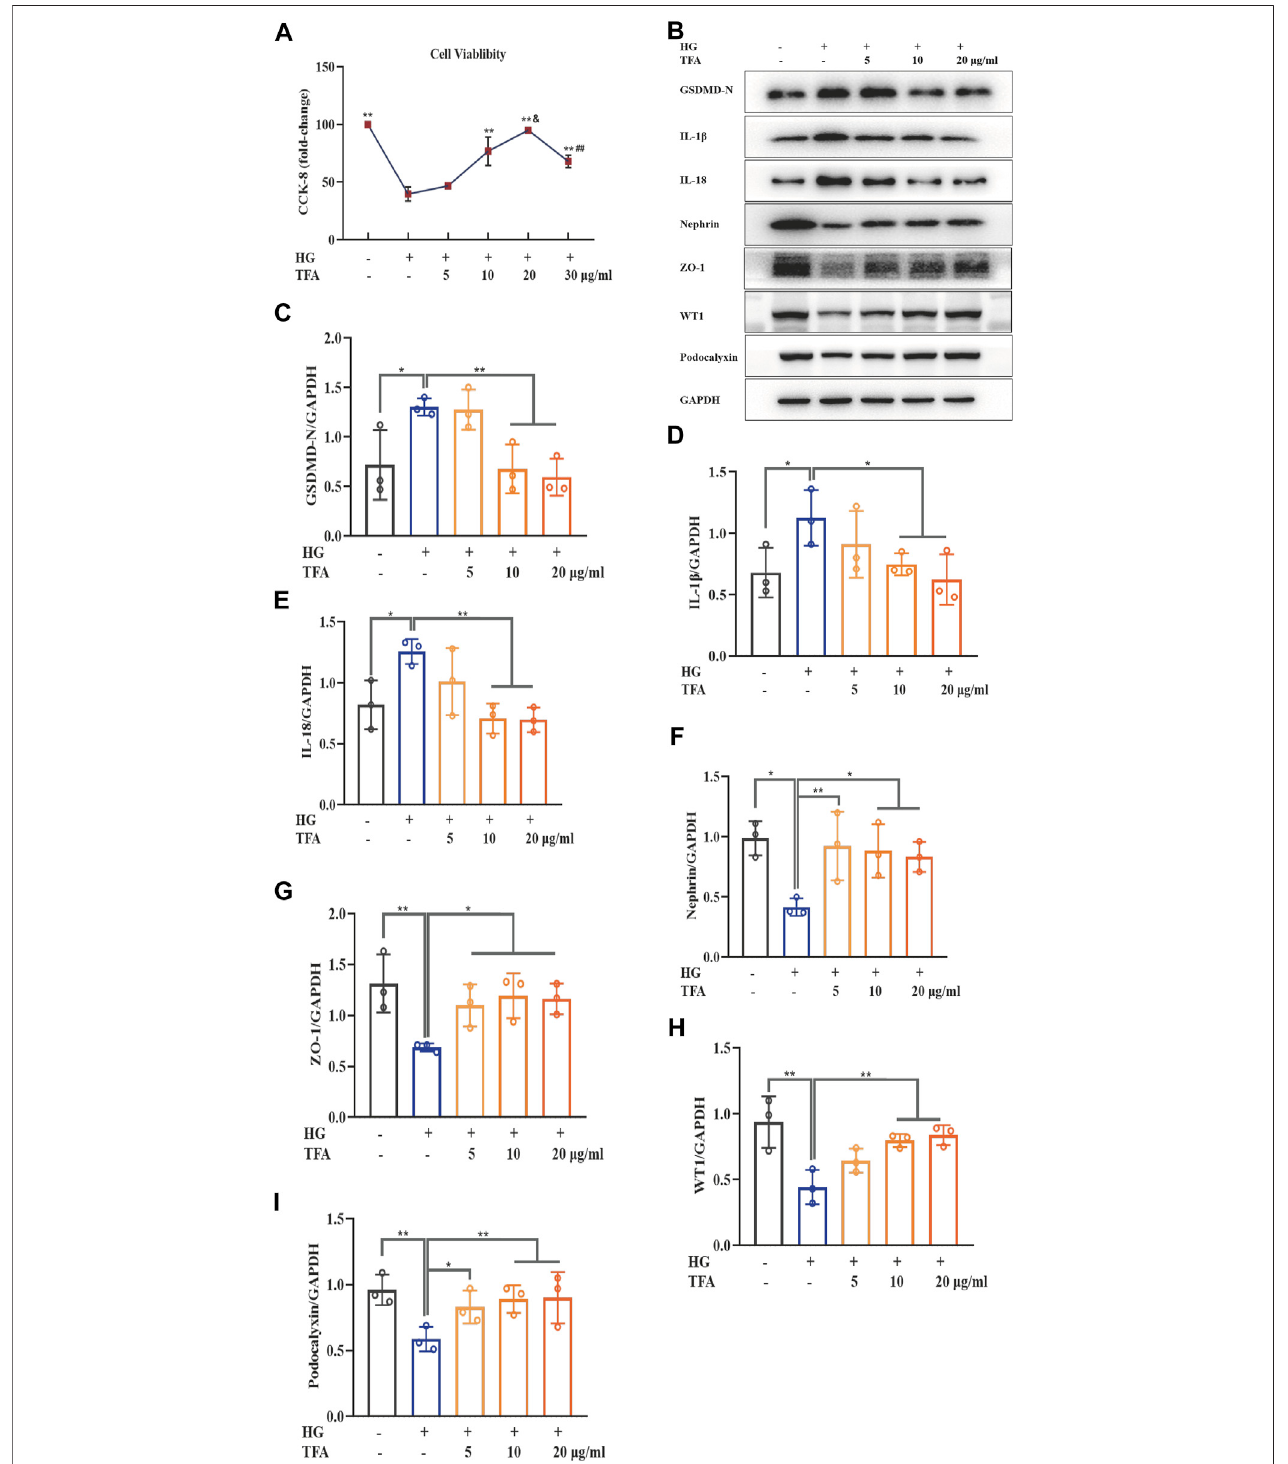
FIGURE1| TFAamelioratedpodocytepyroptosisandinjuryinducedbyHGinMPC-5cellsinadose-dependentmanner. (A) ThecellviabilityinculturedMPC-5cellsexposedtoHGat 30 mMfor48 hwithorwithoutTFAat5,10,20,and30 μ g/mlfor24 h; (B) WBanalysisofGSDMD-N,IL-1 β ,IL-18,nephrin,ZO-1,WT1andpodocalyxininculturedMPC-5cellsexposedto HGat30 mMfor48 hwithorwithoutTFAat5,10,and20 μ g/mlfor24 h; (C) GSDMD-Nwasquanti fi edbydensitometry; (D) IL-1 β wasquanti fi edbydensitometry; (E) IL-18wasquanti fi ed by densitometry; (F) Nephrin was quanti fi ed by densitometry; (G) ZO-1 was quanti fi ed by densitometry; (H) WT1 wasquanti fi ed by densitometry; (I) Podocalyxin was quanti fi ed by densitometry. Data are expressed as mean ± S.D., ( n (cid:2) 3). * p < 0.05, ** p < 0.01 vs. the HG group; & p < 0.05 vs . the TFA (10 μ g/ml) group; ## p < 0.01 vs . the TFA (20 μ g/ml) group. Abbreviations:TFA,total fl avonesof Abelmoschusmanihot ;HG,highglucose;MPC-5,mousepodocytecell-5;WB,westernblotting;GSDMD-N,N-terminusofGSDMD;IL-1 β ,interleukin- 1 β ; IL-18, interleukin-18; ZO-1, Zonula occludens 1; WT1, Wilms tumor type 1.